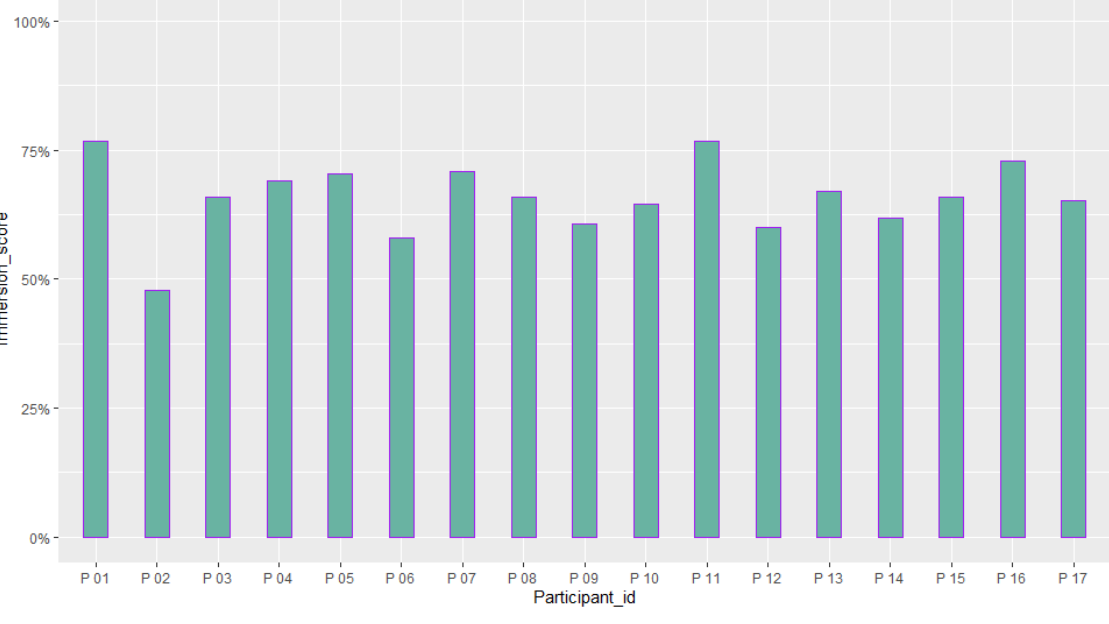
Figure 16. A comparison between the scores obtained from the participants from the Immersive Experience questionnaire (IEQ) (M = 65.84 (%), SD = 7.13